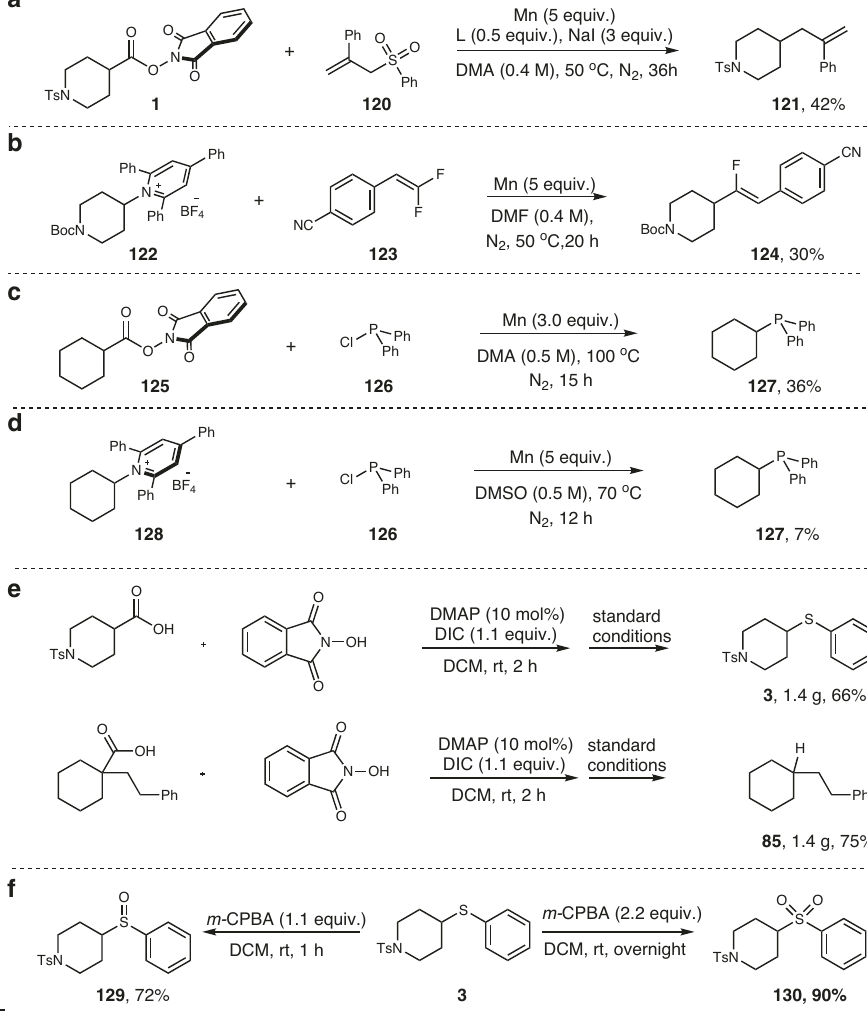
Fig. 9 Miscellaneous reactions and Synthetic Applications. a Decarboxylative allylation. b Deaminative ole fi nation. c Decarboxylative phosphine synthesis. d Deaminative phosphine synthesis. e Gram-scale reaction (in situ activation protocol). f Synthetic